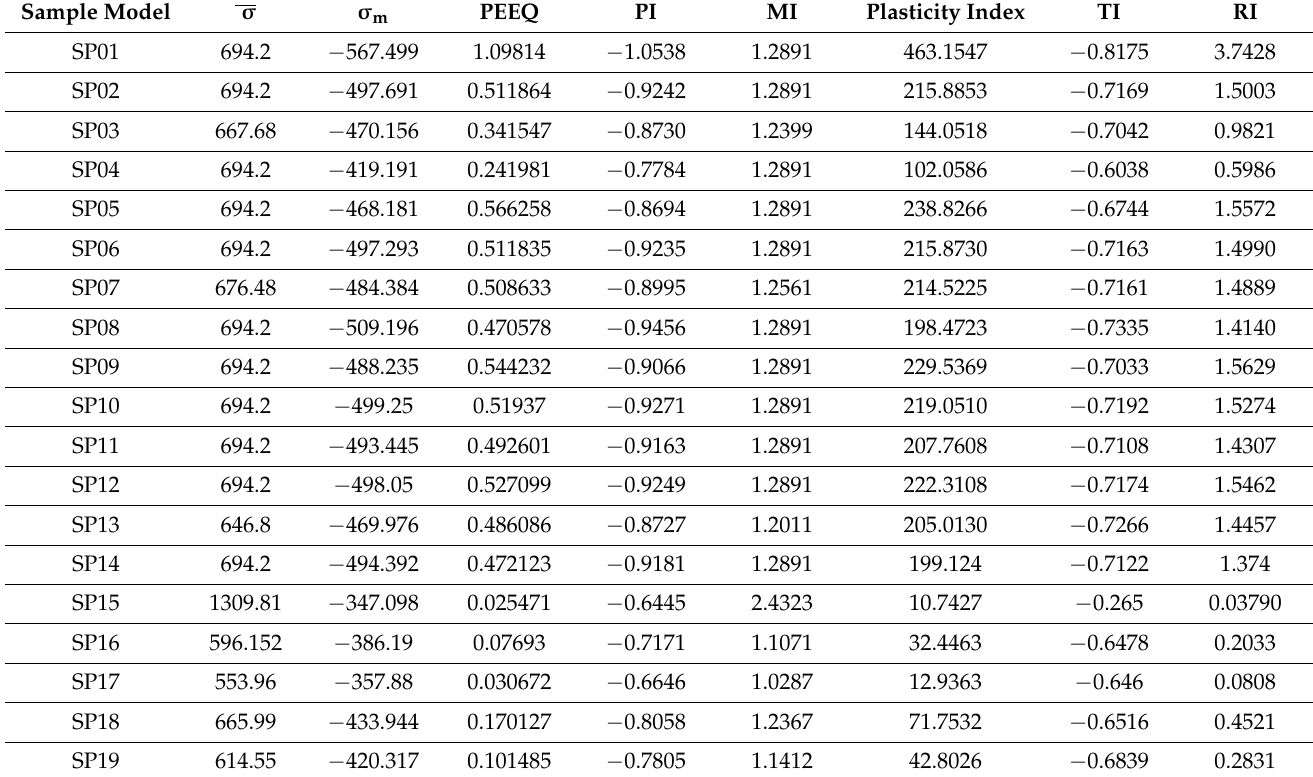
Table 6. Failure indexes for the developed